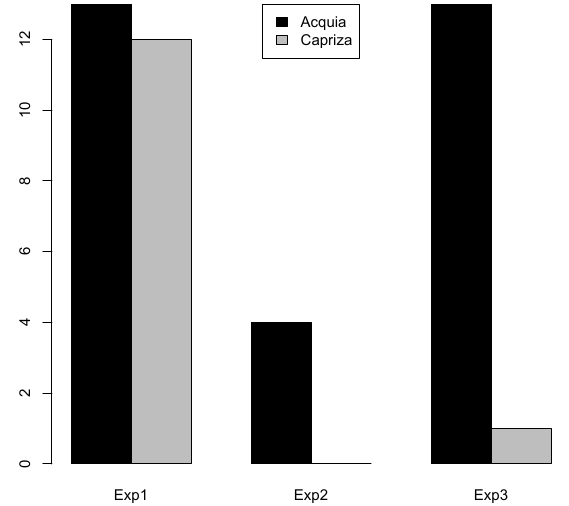
Figure 5. Actual Effectiveness—Cloud Provider Selected in the